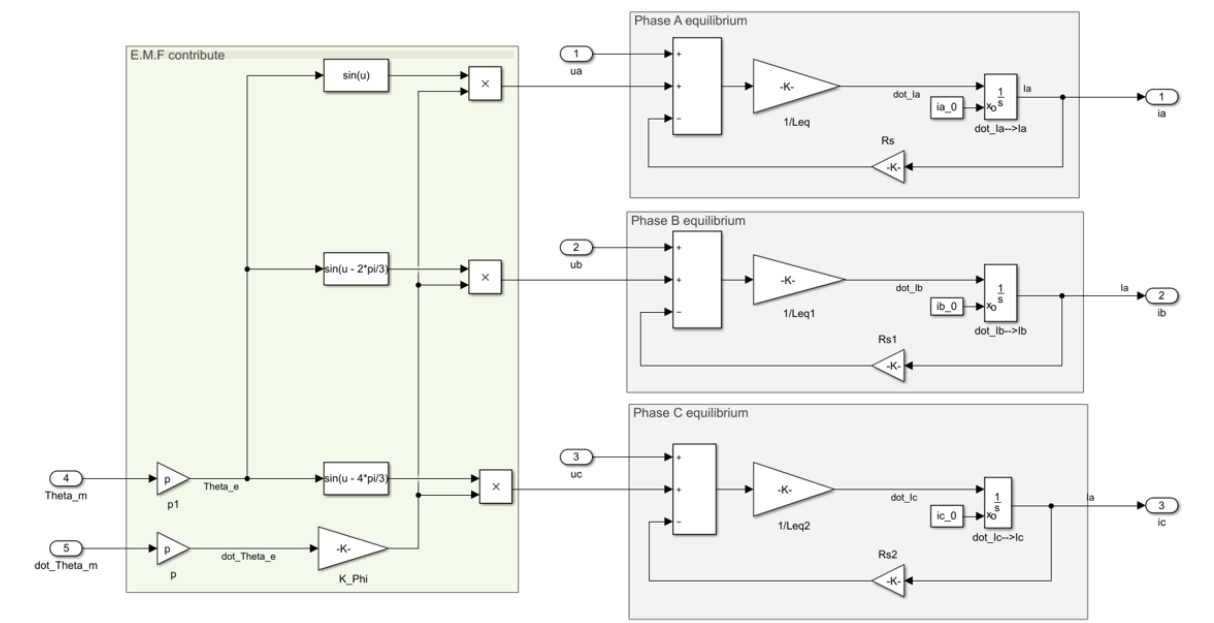
Figure 9. Example realization in MATLAB/Simulink environment of the subsystem related to mechanical equilibrium.